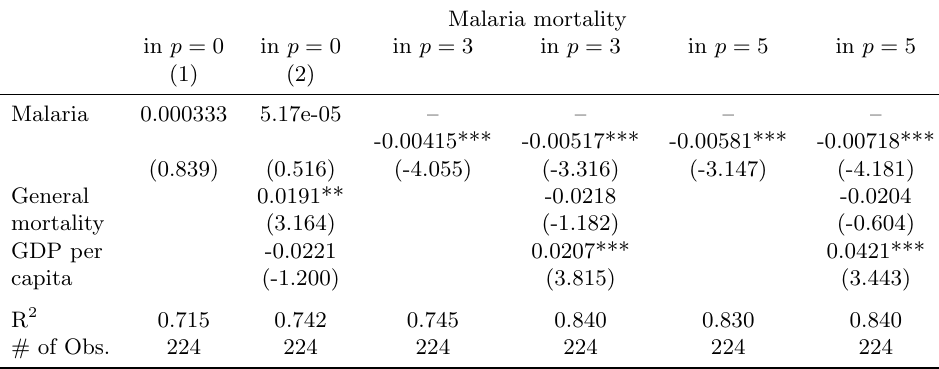
Table 6: Malaria and height (2SLS estimates; second